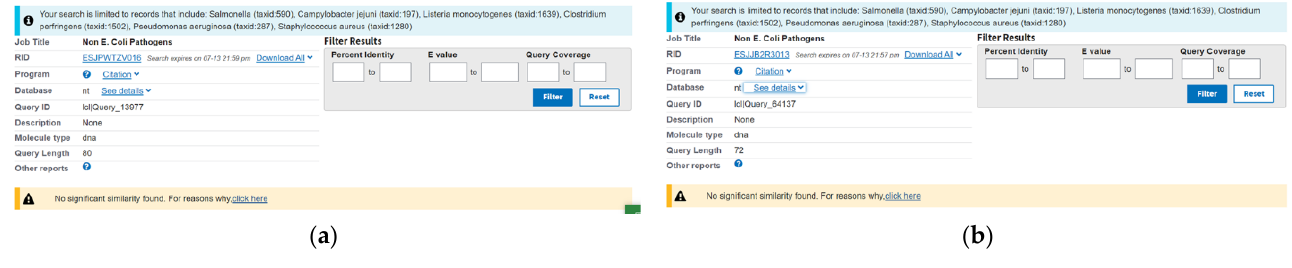
Figure 3. Blast search results of our primers for ( a ) stx1 and ( b ) stx2 against the following organisms: Salmonella enterica, Listeria monocytogenes¸ Campylobacter jejuni, Clostridium perfringens, Staphylococcus aureus. These pathogens were selected based on their implication in food outbreaks. Results searched for highly similar sequences (megablast). These results were obtained from https://blast.ncbi.nlm.nih.gov/Blast.cgi (accessed on 14 July 2021).